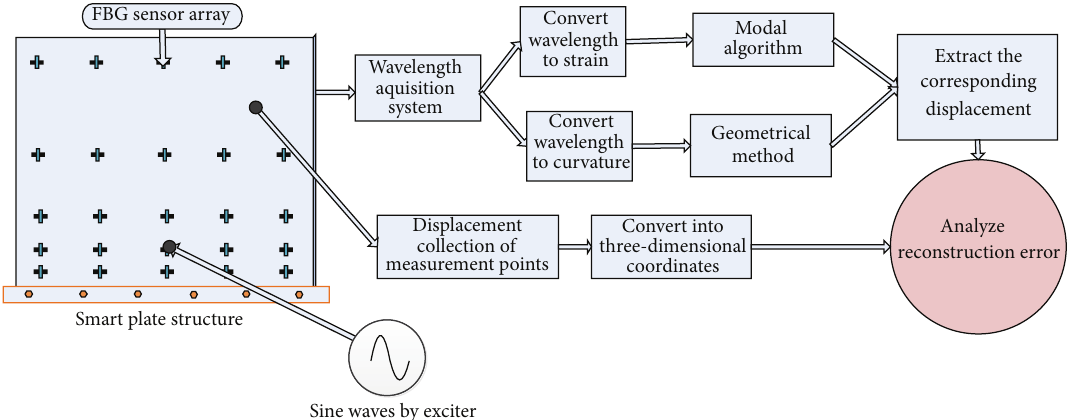
Figure 7: Error analysis principle for vibration shape reconstruction of smart FBG structure.